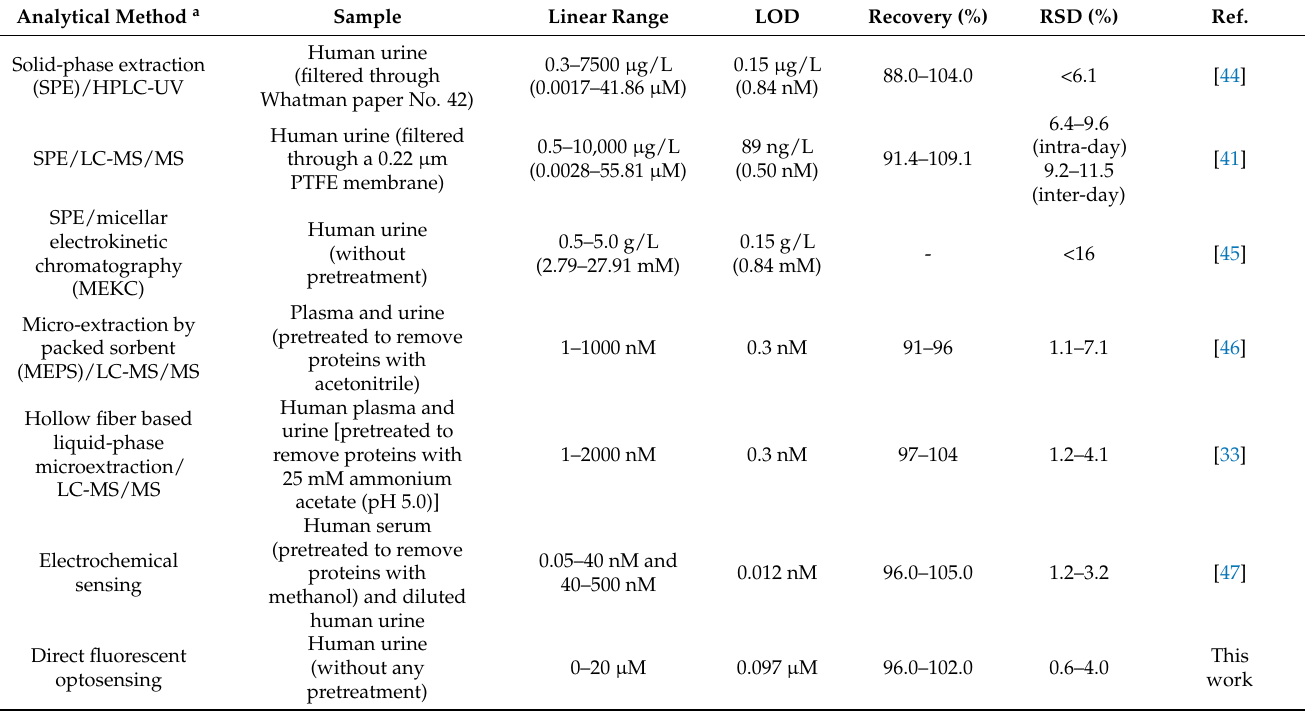
Table 3. Performance comparison of our hydrophilic fluorescent hollow HA-MIP optosensor with other previously reported MIP-based detection systems for